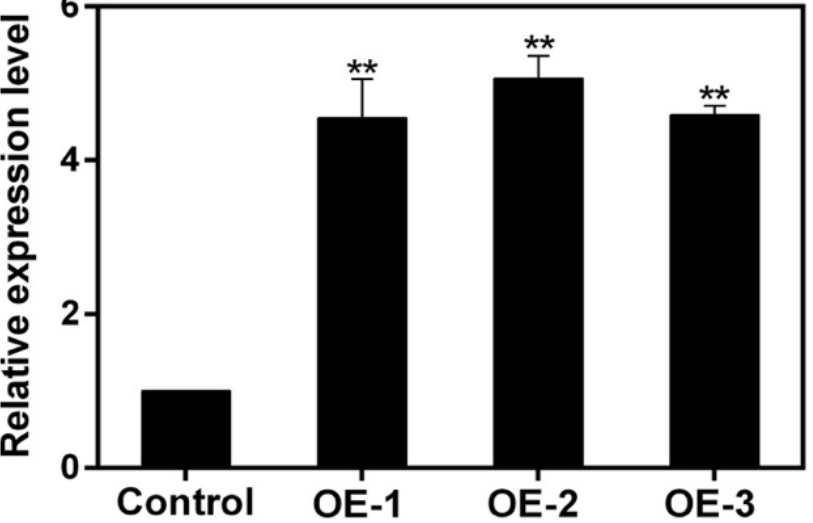
Figure 8. Overexpression of GmNAC3 in three lines of transgenic soybean hairy roots (OE-1, OE-2, and OE-3) relative to control based on quantitative real time PCR (qRT-PCR) analysis. Control: soy- bean hairy roots transfected with Agrobacterium rhizogenes K599. Symbols “**” indicate significant differences at p value of